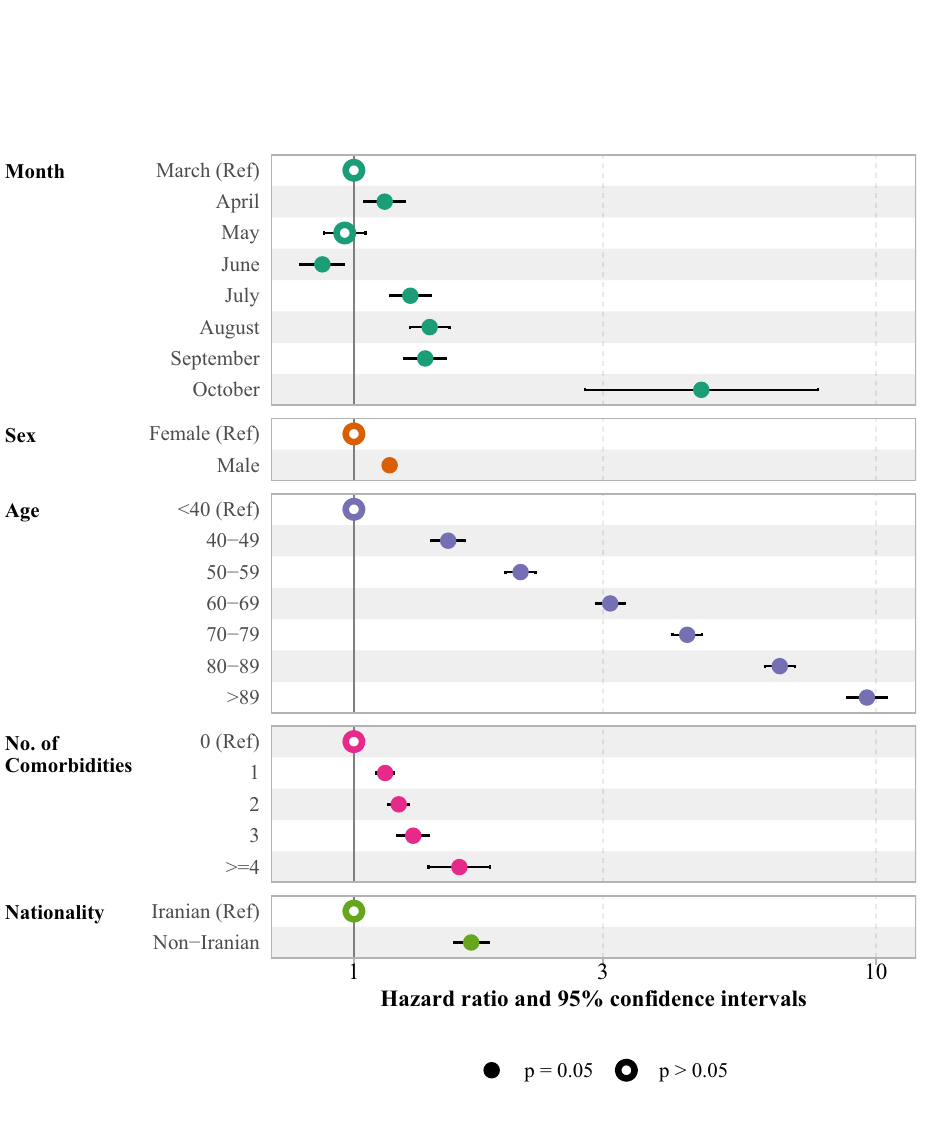
Figure 2. The forest plot of death hazard ratio among hospitalized patients of COVID-19. The Cox proportional model was adjusted for month of admission, sex, age, no. of comorbidities and